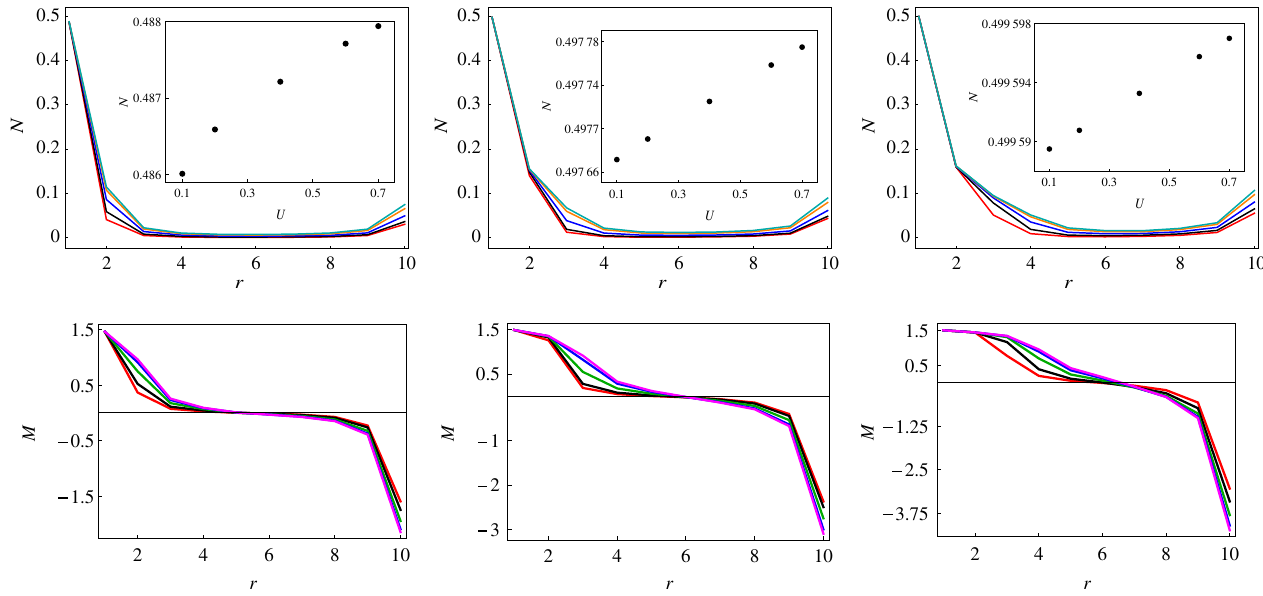
FIG. 4. Upper panels: Spatial variation of the local Néel ( N ) order parameter, obtained from the self-consistent solution of the magnetic ground state, as in Eq. (9), for various subcritical Hubbard interactions, and bell-shaped localized axial flux peaked around the center of the system. The strength of the Hubbard interaction in each plot reads as U ¼ 0 . 1 (red line), 0.2 (black line), 0.4 (blue line), 0.6 (orange line), 0.7 (dark green line) from bottom to top. Total flux of the localized axial field reads as Φ from left to right, where Φ 0 is the flux quanta. Inset in upper panels: Variation of N ð r Þ at the center of the system with the strength of the on-site interaction. Lower panels: Spatial variation of local ferromagnet order ( M ) in the same magnetic ground state for U ¼ 0 . 1 (red line), 0.2 (black line), 0.4 (dark green line), 0.6 (blue line), 0.7 (magenta line). Total flux of the localized axial field in the lower panel is same as in upper one. Here, N and M are the same as in Fig.